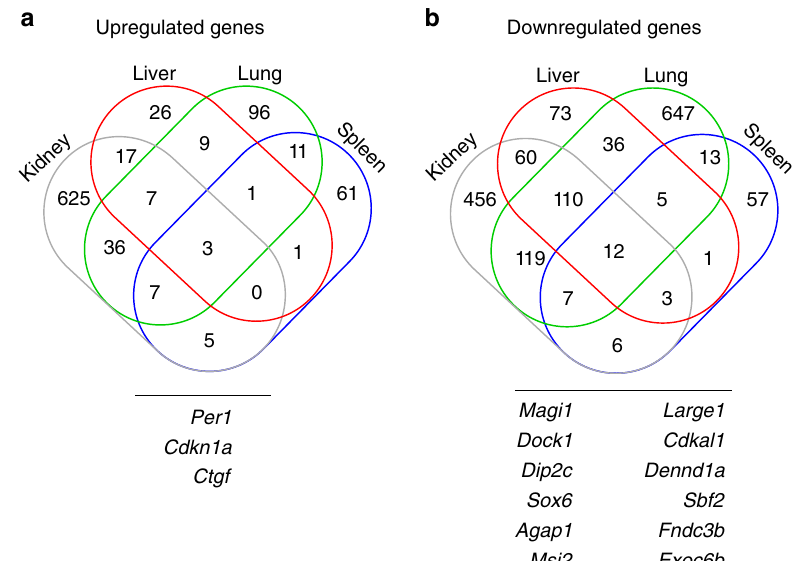
Fig. 2 Cisplatin-induced differential gene expression between treated and control groups. Venn diagram shows the numbers of signi fi cantly differentially expressed genes across mouse kidney, liver, lung, and spleen four hours after treatment with cisplatin. a Three genes are signi fi cantly upregulated. b Twelve genes are signi fi cantly downregulated in all mouse